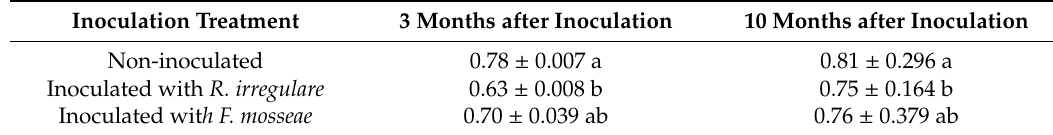
Table 1. Root mycorrhizal colonization rate three months after inoculation ( n = 3) and ten months after inoculation ( n = 5) in ‘Touriga Nacional’ variety vines grafted onto 1103 Paulsen rootstock. Data represent the average values ± standard error. Di ff erent letters indicate significant di ff erences in group means for each time point according to Duncan’s a posteori test. Significant e ff ect, p -value < 0.05.